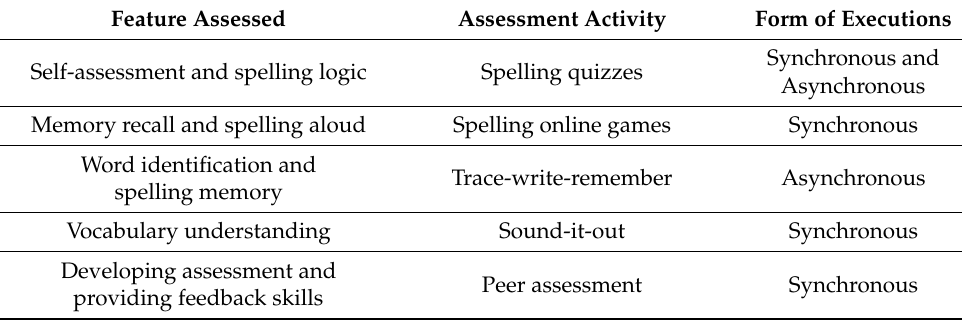
Table 2. Spelling Assessment